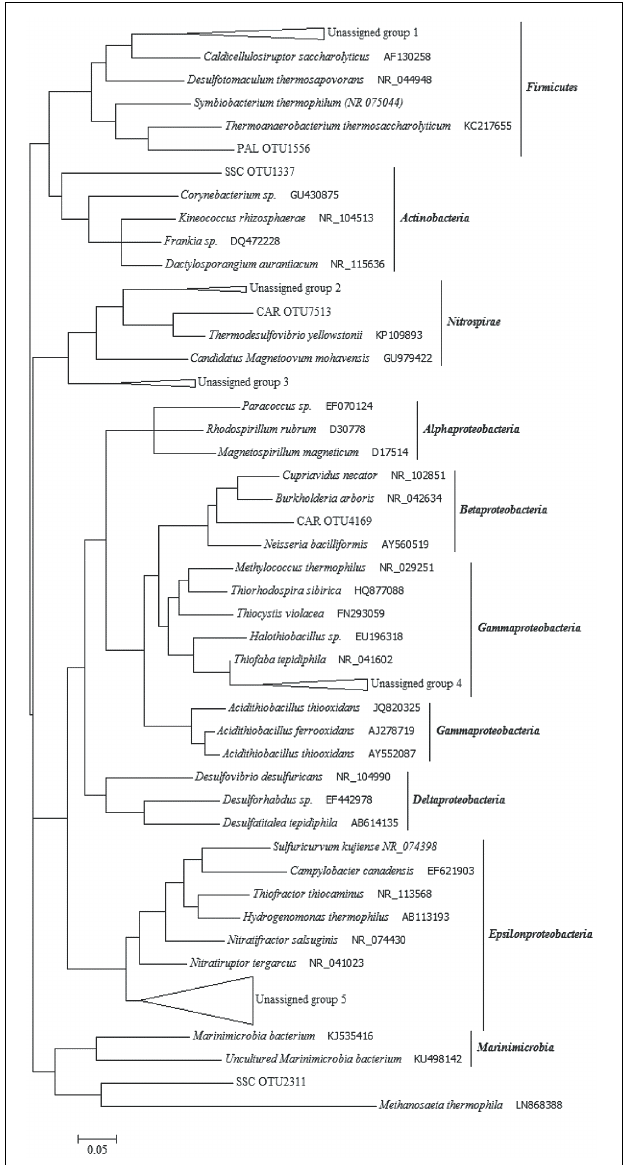
FIGURE 8 | Arsenic-related genes abundance (gene copies/ml) estimated by qPCR in thermal waters, groundwaters and lake